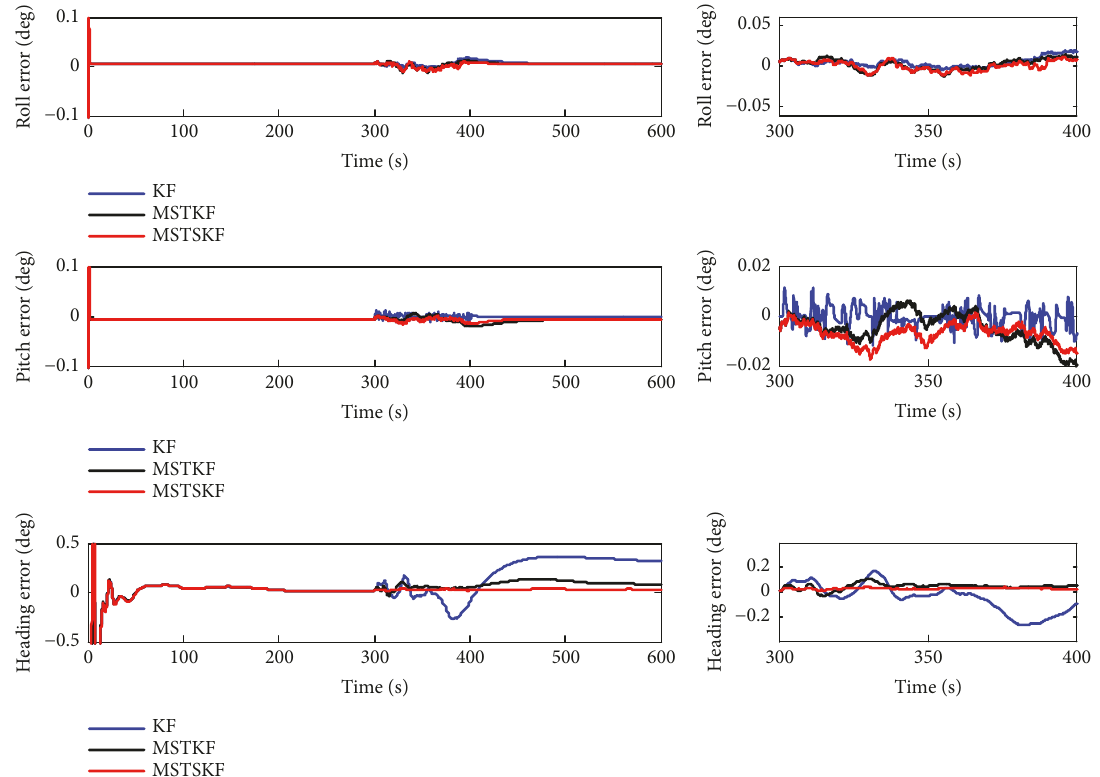
Figure 2: Attitude angle error of the simulation when the system noise has a sudden change.